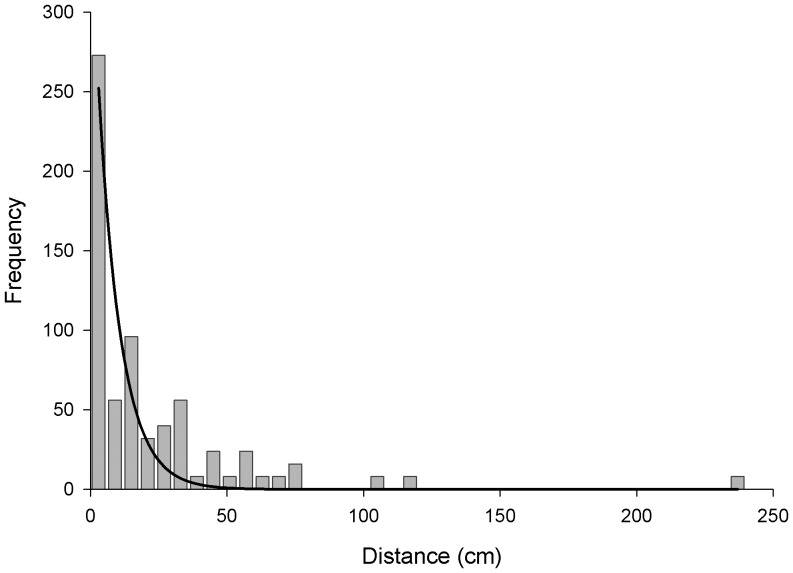

M. vimineum Non-riparian Water Dispersal Frequency Distribution.Frequency distribution of M. vimineum seed (excluding un-dispersed seed) from a total of 5000, dispersed by non-riparian water dispersal binned into 6 cm long segments after 4 rain events totaling in 52.3 mm of rain. Line represents best-fit logarithmic curve (y = 361.2−0.12x).